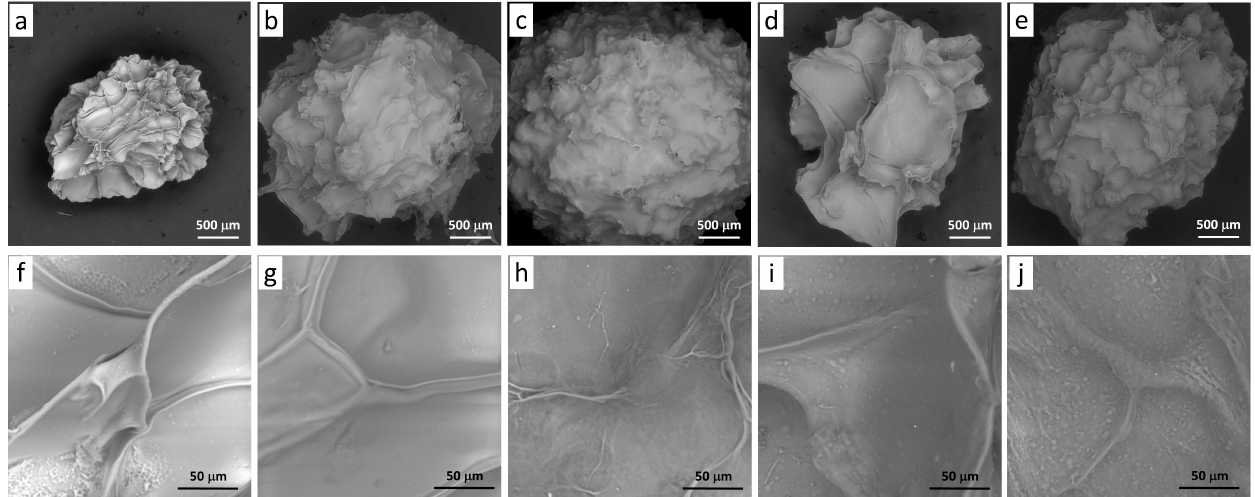
Figure 2. Scanning electron micrographs of GSE-loaded particles: Alg1.0 ( a , f ), 0.17SVC-1.0Alg ( b , g ), 0.5SVC-1.0Alg ( c , h ), 0.17LMC-1.0Alg ( d , i ), and 0.5LMC-1.0Alg ( e ,j). Magnification 63×, scale bar 500 μ m ( a – e ) and magnification 948×, scale bar 50 μ m ( f – j ).